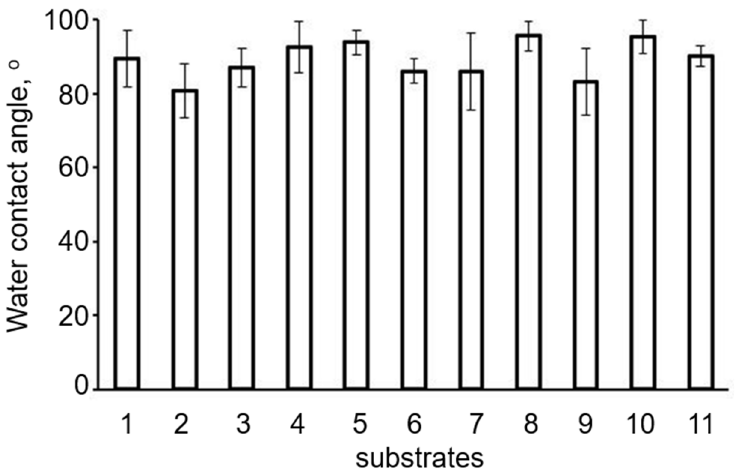
Figure 7. Water contact angles of the films prepared from PHAs synthesized from various carbon sources by Cupriavidus necator IBP/SFU-1 (numbering of Samples 1–11 is the same as in Table 1).